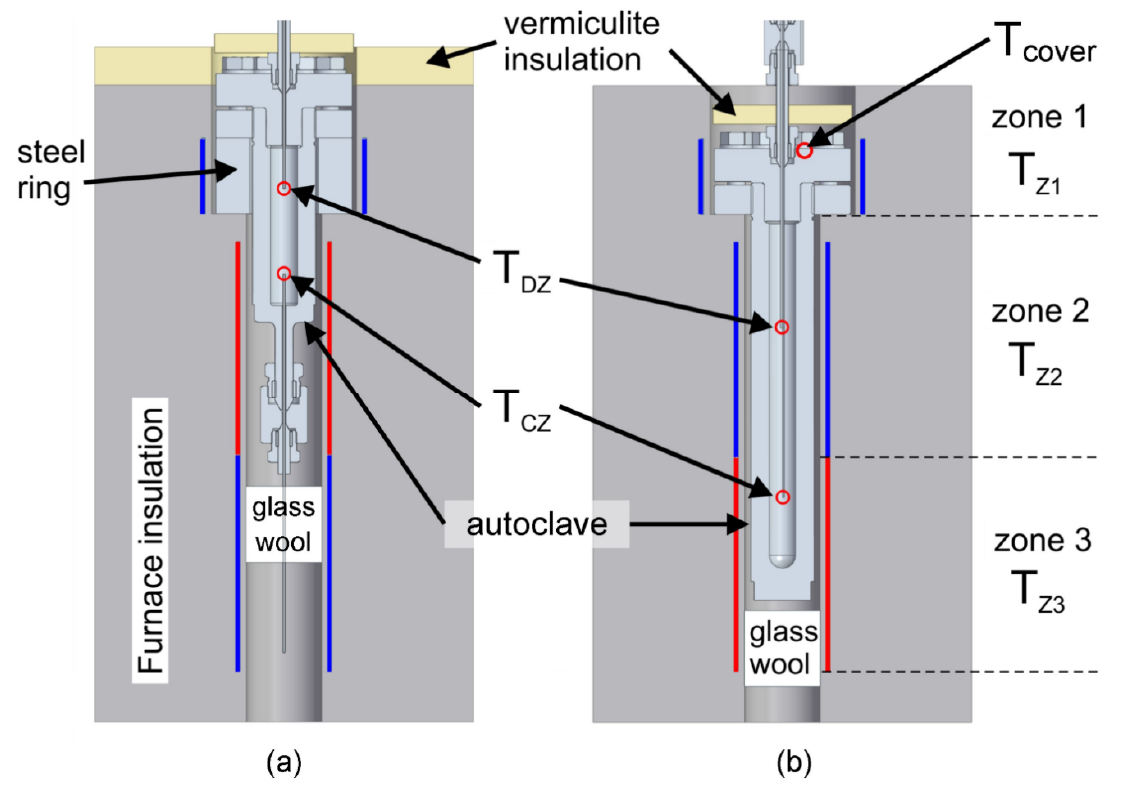
Figure 1. Experimental setups: ( a ) Experiment A1, A2 and A3, ( b ) Experiment B. For setup A, the positions of the internal temperature measurements are 34 mm below the top inner wall and 25 mm above the bottom inner wall. For setup B, the positions are 85 mm below the top inner wall and 55 mm above the bottom inner wall, respectively. Reprinted based on [21].